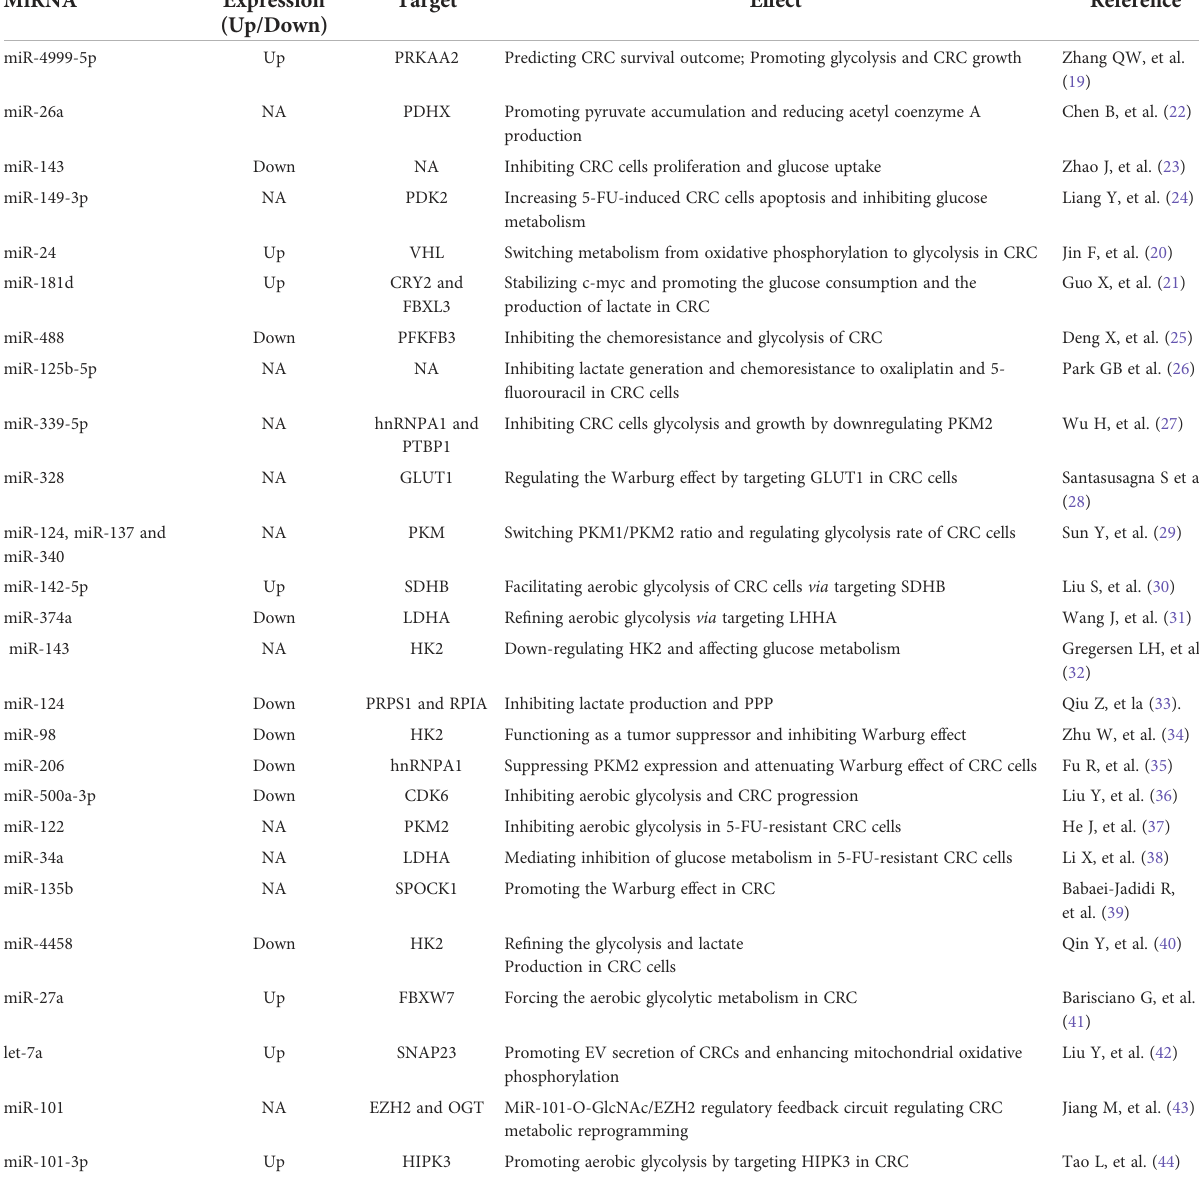
TABLE 1 MiRNAs involved in CRC glucose metabolism. MiRNA Expression (Up/Down)